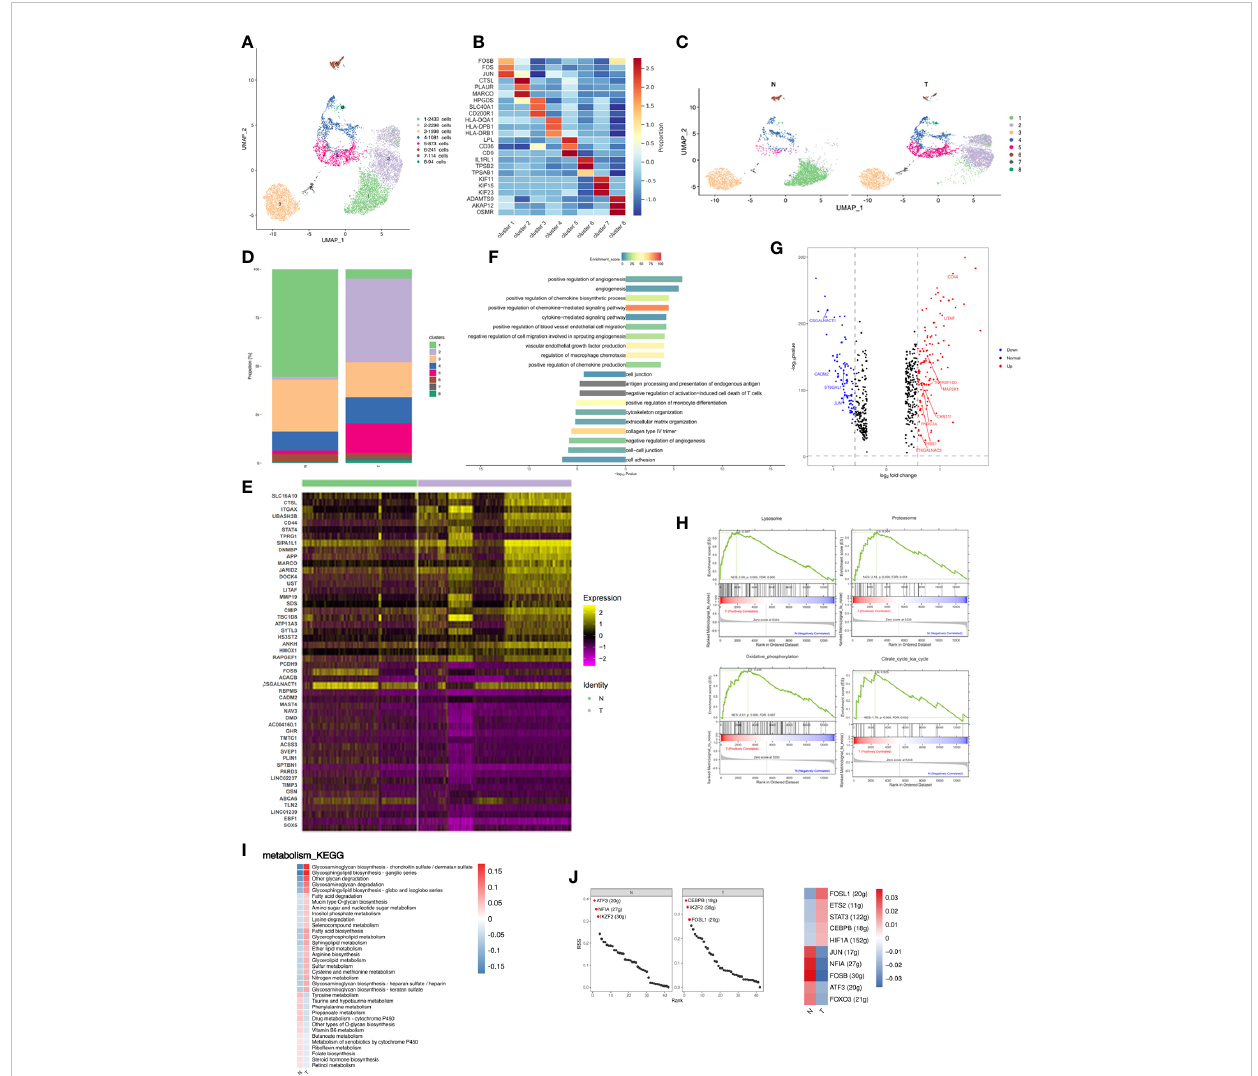
FIGURE 2 Breast cancer remodels the macrophage composition in adipose tissues. (A) UMAP plot of 8 clusters of macrophages from the 6 samples pro fi led in this study, with each cell color coded to indicate the associated subclusters and cell numbers. (B) Heatmap showing the expression of macrophage subpopulation marker genes in each cluster. The color changes from blue to red, indicating a low to high fold change. (C) UMAP plot of all macrophage subpopulations annotated in each group, with each cell color coded to indicate the associated subclusters. (D) The relative ratio of macrophages in N and T group shown using bar plots, with each cell color coded to indicate the associated subclusters. (E) Heatmap showing the top 25 differential expression genes (up- or down-regulated). The color changes from blue to red, indicating a low to high fold change. (F) Barplot showing the signi fi cance levels of the top 10 most signi fi cantly enriched pathways in all DEGs. The left side of the coordinate axis represents the enriched functional pathway of down-regulated genes; The right side of the coordinate axis represents the enriched functional pathway of up- regulated genes. (G) Expression of genes (N versus T) involving in in fl ammatory (GO:0006954) in macrophages. (H) The top 4 GSEA analysis of MARCO + macrophages (cluster 2). (I) Heatmap indicating the enrichment of metabolism signaling pathway on all macrophages in N and T group. (J) The regulon speci fi city score (RSS) ranking plot of top 3 TFs in N and T group. The abscissa represents the ranking, and the ordinate represents the RSS score. The regulator with higher RSS may be related to the speci fi city of this cell group (upper). Heatmap showing the regulon activity in N and T group. Rows represent different regulons, and columns represent different cell populations. The color changes from blue to red, indicating a low to high RSS speci fi city score. The higher the RSS score, the stronger the speci fi city of regulon in this cell group (lower). The number of target genes shown in